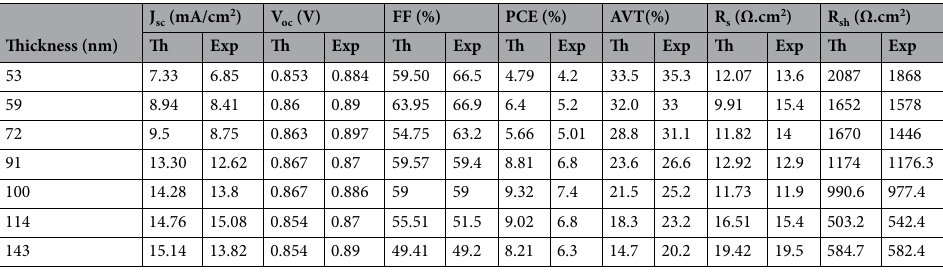
Table 2. The calculated characteristic parameters of the ITO/ZnO/PBDB-T:ITIC/MoO 3 /Ag/MoO 3 structures with a variation of PBDB-T:ITIC active layer thickness in comparison to experimental data 31 . MoO 3 /Ag/MoO 3 thickness is fixed to (6 nm/10/nm/40 nm).